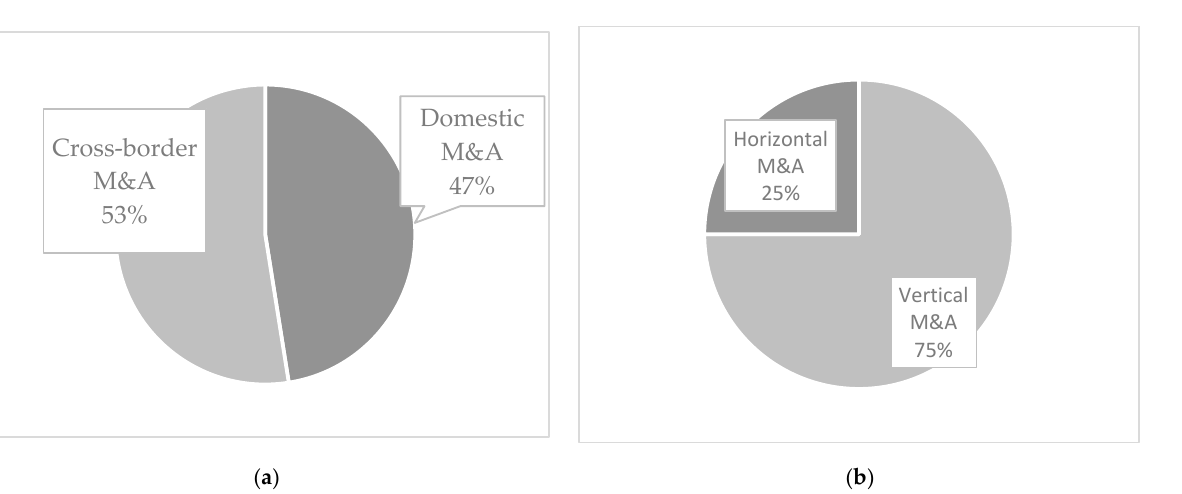
Figure 6. Descriptive statistics: ( a ) Cross-border vs. domestic M&A; ( b ) horizontal vs. vertical M&A. Source: authors’ calculations.